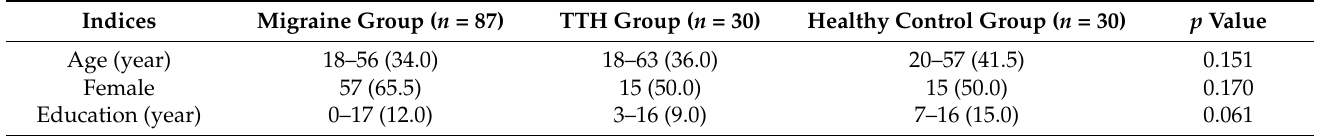
Table 1. General conditions in the migraine, TTH, and healthy control